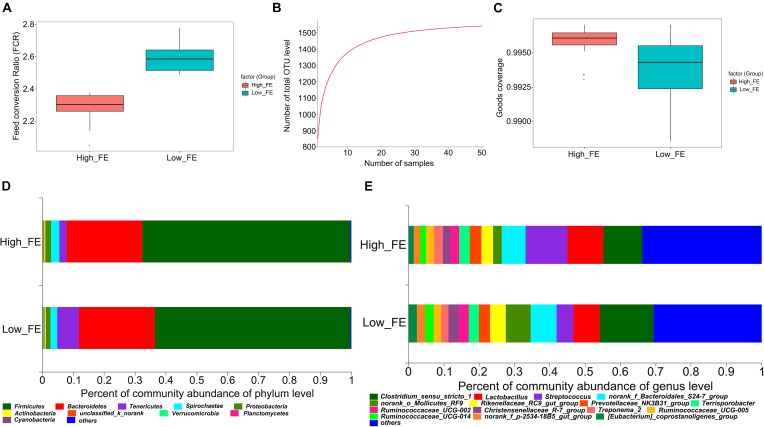
The feed conversion ratio value (FCR), pan OTUs, Good’s coverage and community composition in high- and low-feed-efficiency (FE) pigs. Groups are coded according to the feed efficiency status (High_FE, high feed efficiency; Low_FE, low feed efficiency). (A) FCR value in high- and low-FE pigs. (B) Pan OTU = sample size. The horizontal axis represents the number of samples. The vertical axis represents the number of OTUs contained in all samples. (C) Good’s coverage value in high- and low-FE pigs. (D) Community composition at the phylum level in high- and low-FE pigs. (E) Community composition at the genus level in high- and low-FE pigs.